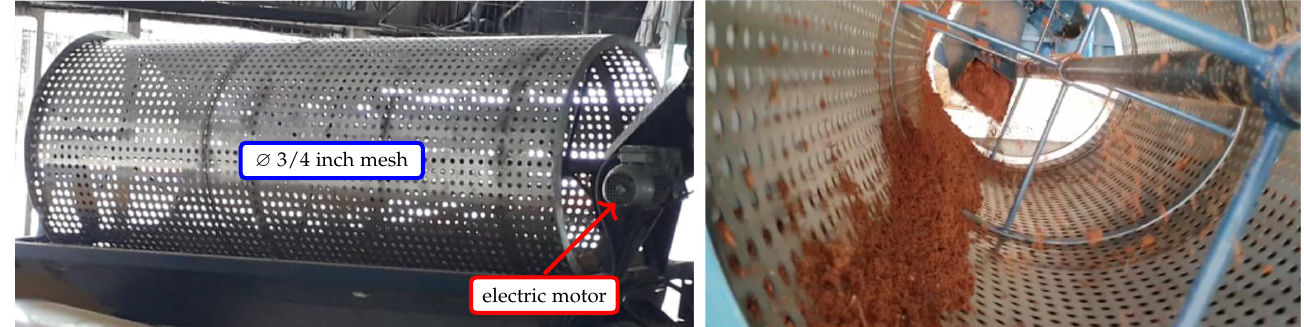
Figure 4. Screening of wood residues.